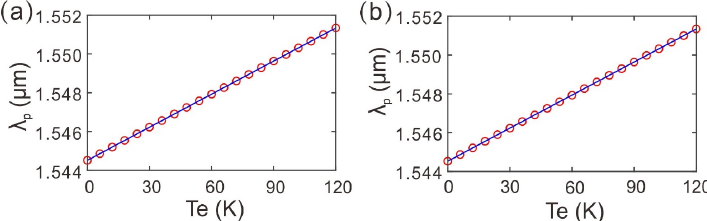
Figure 5. ( a , b ) Variation of the central wavelength of the defect mode with the environmental tem- perature for different values of period number of photonic crystals. The period number is N = 3 for ( a ) and the period number of is N = 4 for ( b